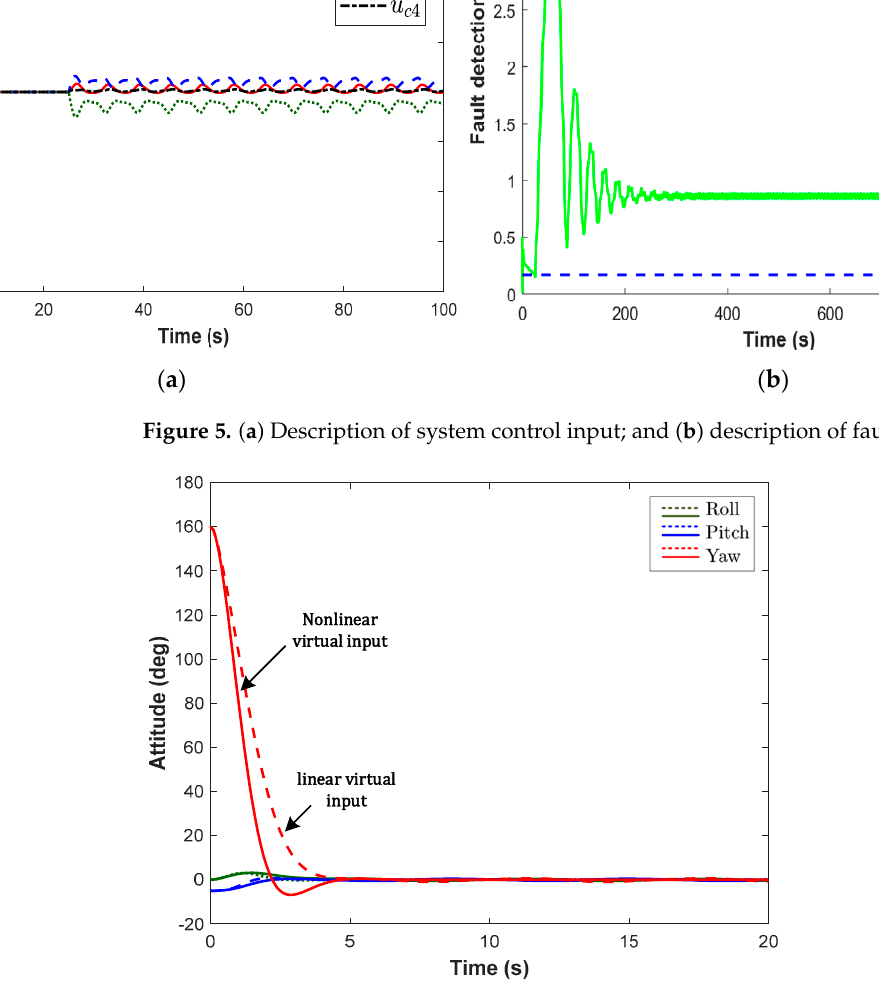
Figure 6. Comparison of transient performance under ideal input.